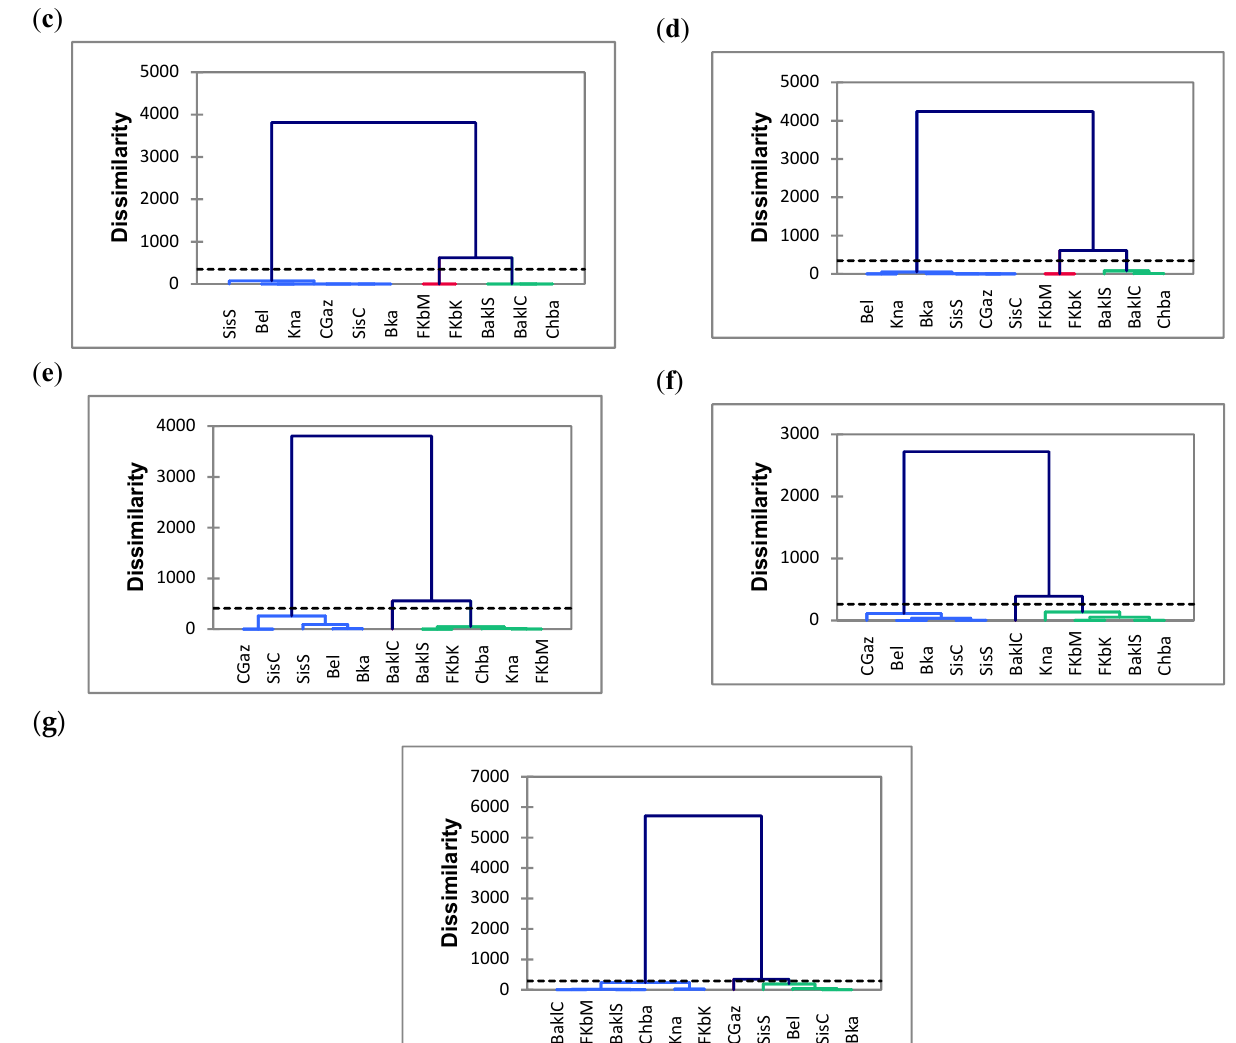
Figure 5. Cluster analysis based on the phytochemical compounds and antioxidant activity (by DPPH and FRAP assays) analyzed at 10 ( a ), 25 ( b ), 40 ( c ), 55 ( d ), 70 ( e ), 85 ( f ) and 100 DAA (days after anthesis) ( g ) in the eleven Tunisian chili pepper accessions. TPC: total phenol content. TFC: total flavonoid content. CAP: capsaicin content. See caption to Figure 2 for the list of acronyms used for the studied accessions. Table 6. Bivariate correlations among the studied quantitative traits in the eleven Tunisian pepper accessions.